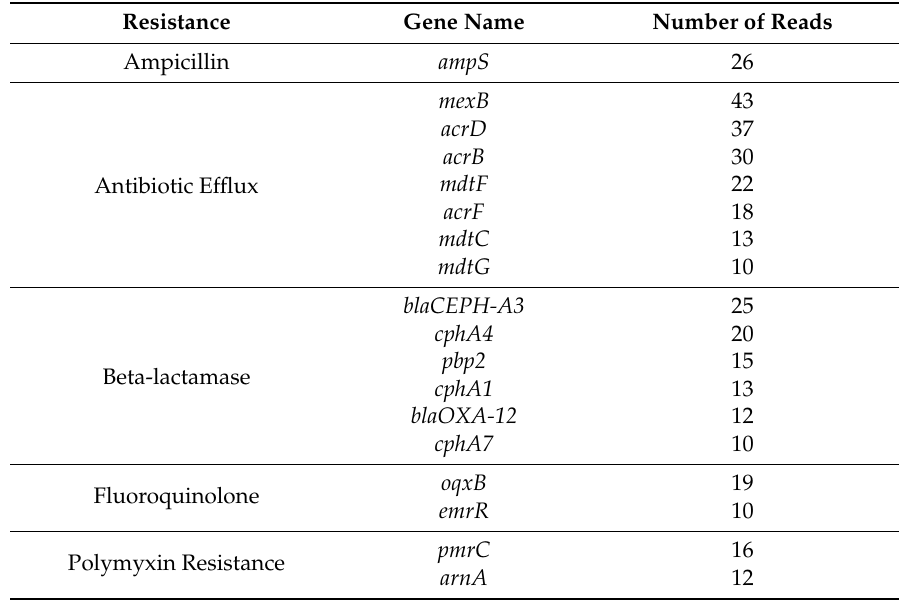
Table 6. Antibiotic resistance markers identified by CosmosID analysis of DNA prepared from filtered water sample after selective growth on m-ColiBlue24 medium.